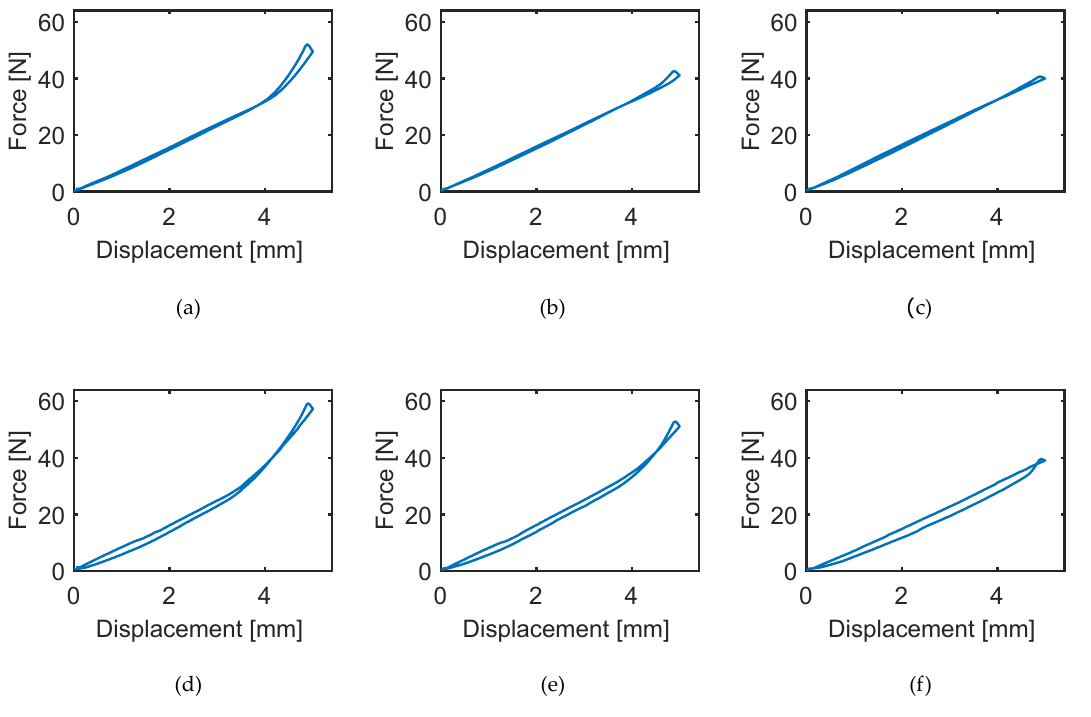
Figure 11. Isobaric tests: comparison between soft actuator alone at 50 kPa ( a ), 100 kPa ( b ) and 200 kPa ( c ) and hybrid actuator at 50 kPa ( d ), 100 kPa ( e ) and 200 kPa ( f